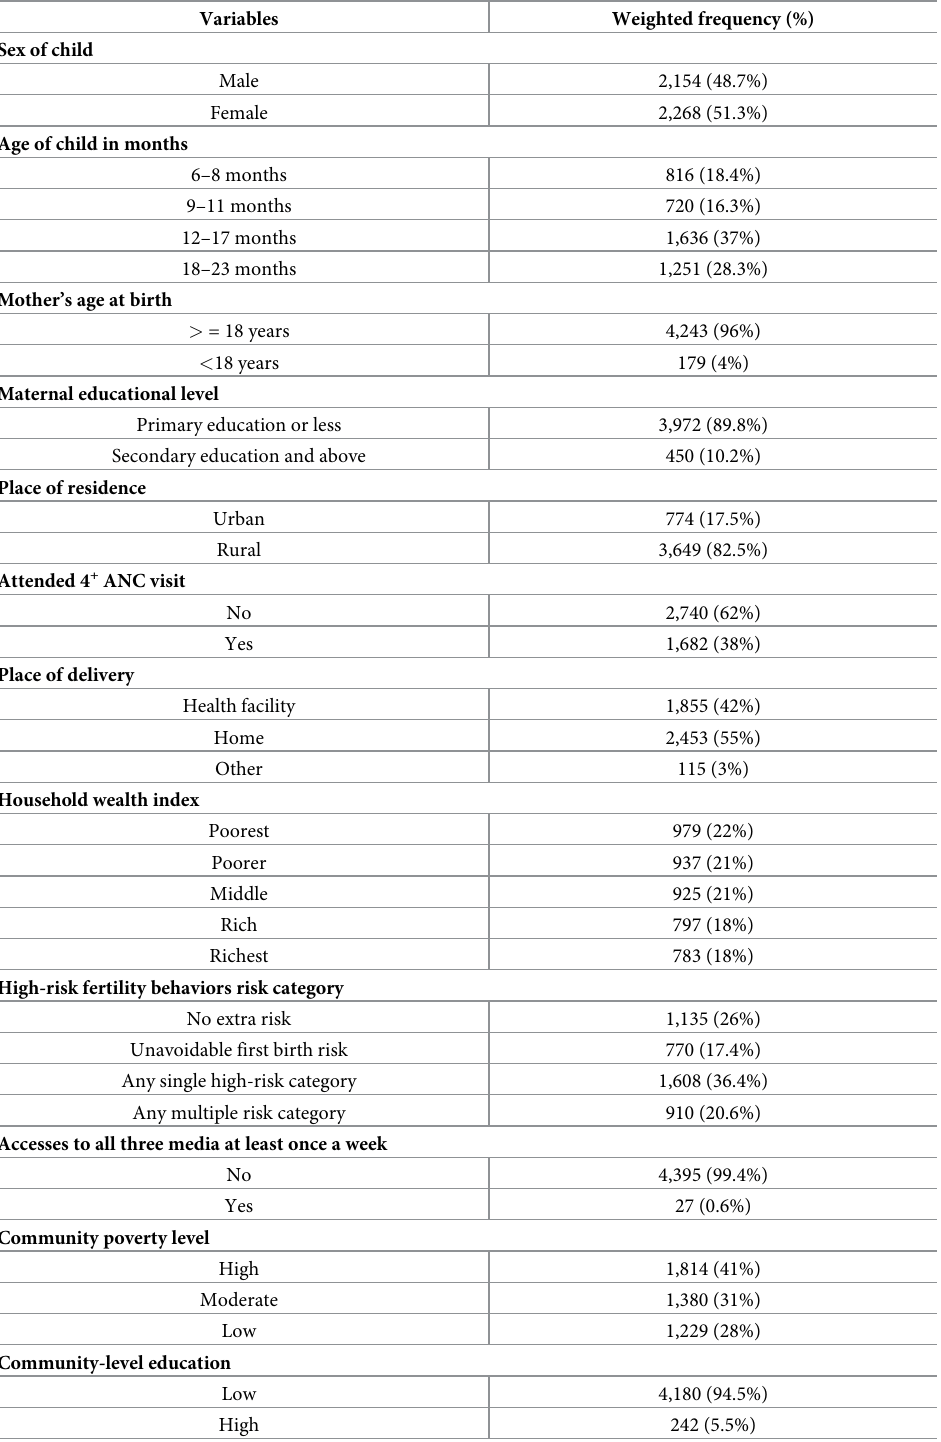
Table 1. Individual-and community-level characteristics of participants, pooled data from Ethiopia DHS 2016 & 2019 (n =